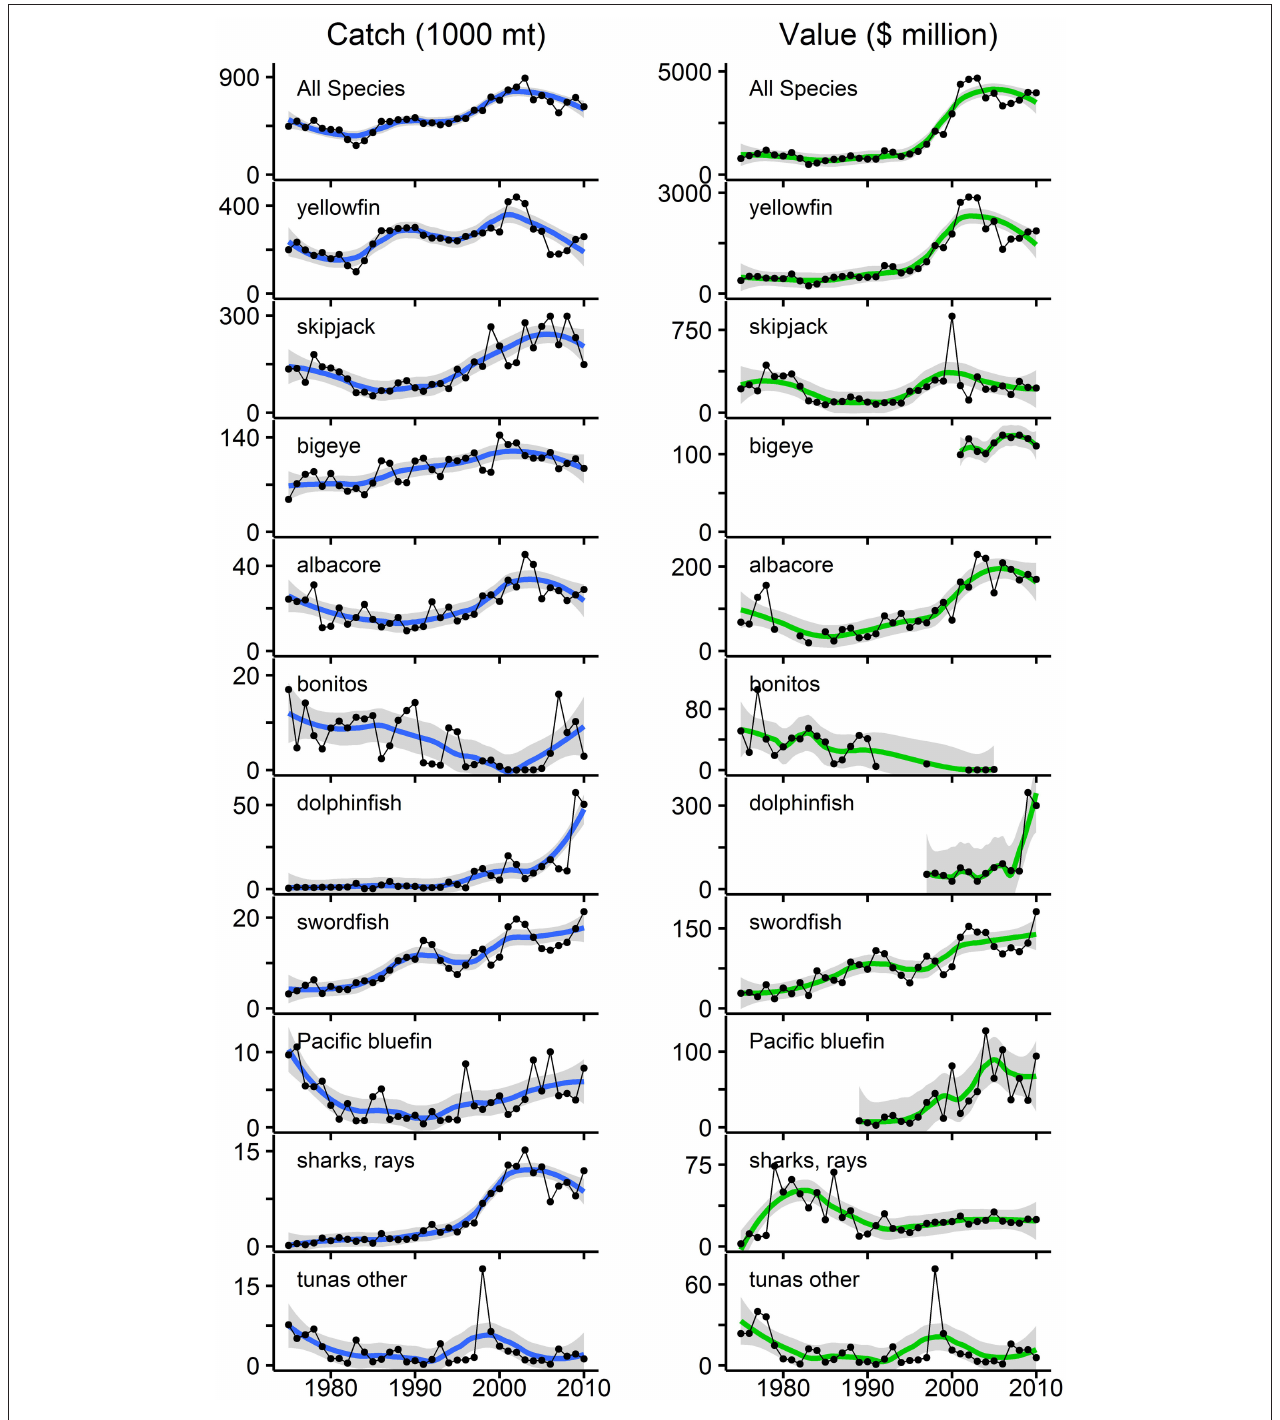
FIGURE 3 | Annual catch and estimated catch value (using U.S. import prices) for the top 10 commercially fished species groups in the eastern tropical Pacific (ETP) for 1975–2010. These 10 groups rank highest in terms of maximum annual catch ( Table 1 ). “Tunas other” corresponds to “tunas nei” from Table 1 and represents all tunas not assigned to individual species groups. All gear types and fishing nations are represented. Left panels are annual catch in mt; right panels are estimated catch value in millions of 2010 U.S. dollars (adjusted for inflation). Note: the scales for catch and value vary by species group. Data points are connected with lines for sequential years; breaks appear where no data were available. LOESS smoothed trend lines are displayed with shaded 95% confidence intervals. The top panel is the sum of the 10 species groups. Over 35 years, cumulative catch and catch value were 19.6 million mt and $67.4 billion,